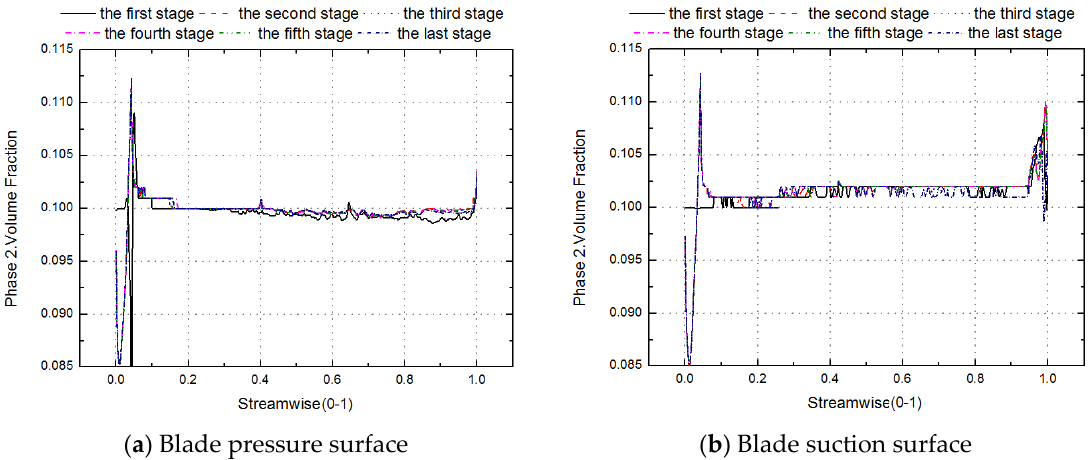
Figure 14. The distribution law of the GVF from the inlet to the outlet at the height of 0.8 times the blade height.